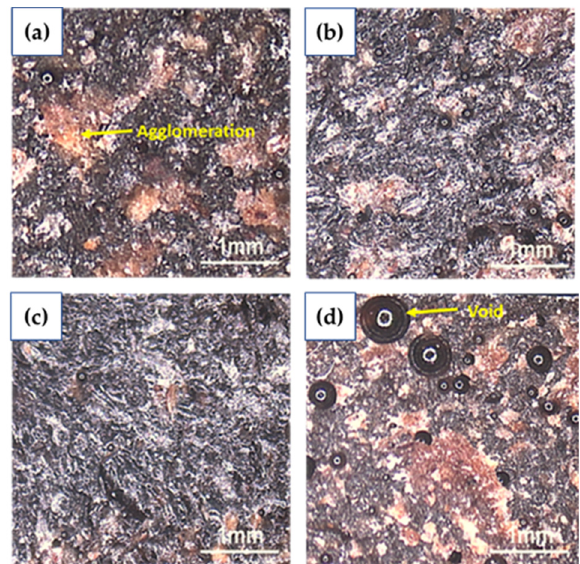
Figure 5. Microscopic of a tensile fractured UPKCF composites; ( a ) 10, ( b ) 20, ( c ) 30, and ( d ) 40 wt.%.